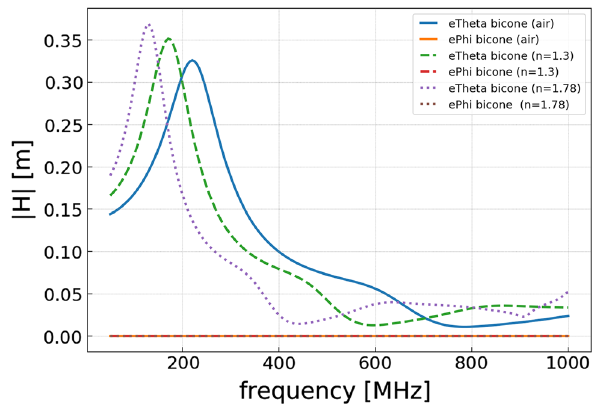
Fig. 10 The (open circuit) vector effective length of a WIPL-D simu- lation of the ’birdcage’ bicone antenna [23] in different media (air and ice with different refractive indices